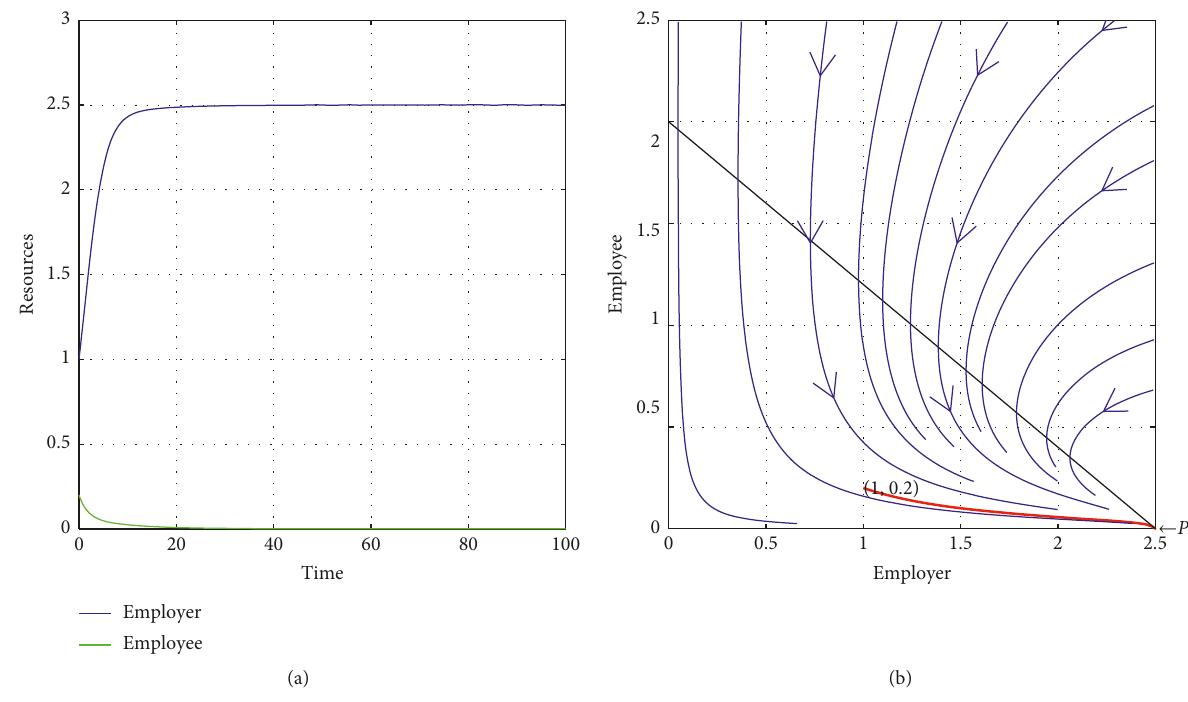
Figure 3: The simulation result and the phase diagram in the employer win situation.